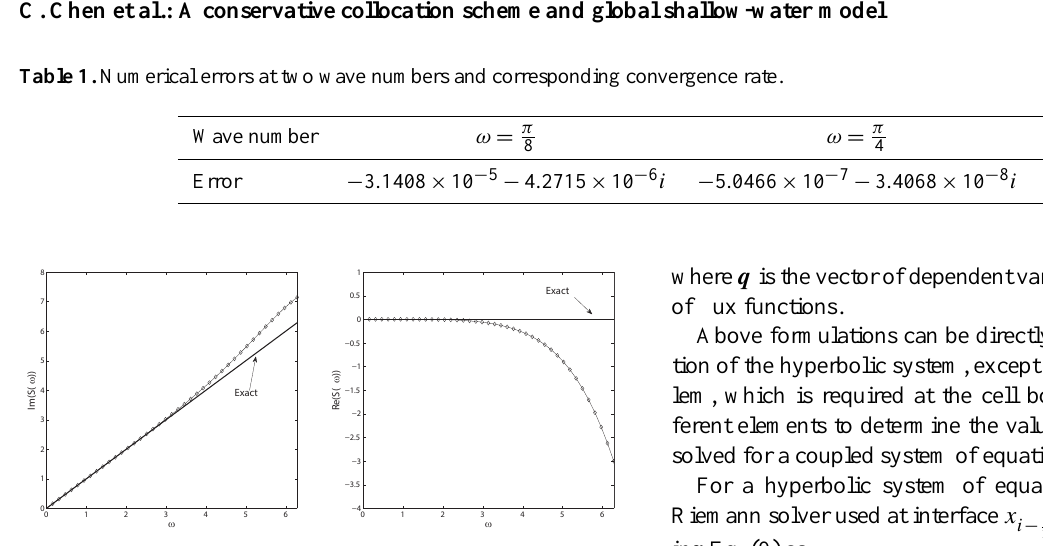
Figure 3. Numerical dispersion (left) and dissipation (right) rela- tions of the semi-discrete